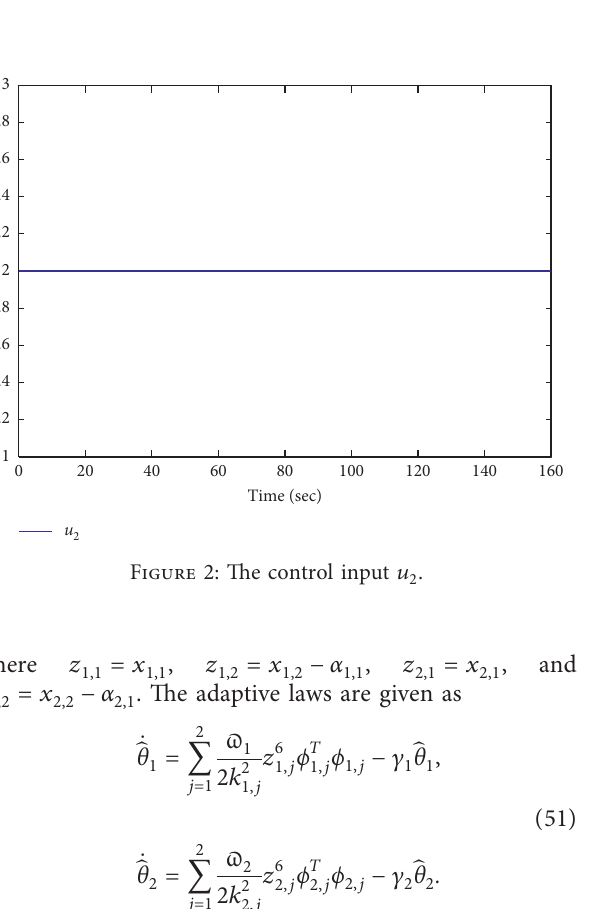
Figure 1: The control input u